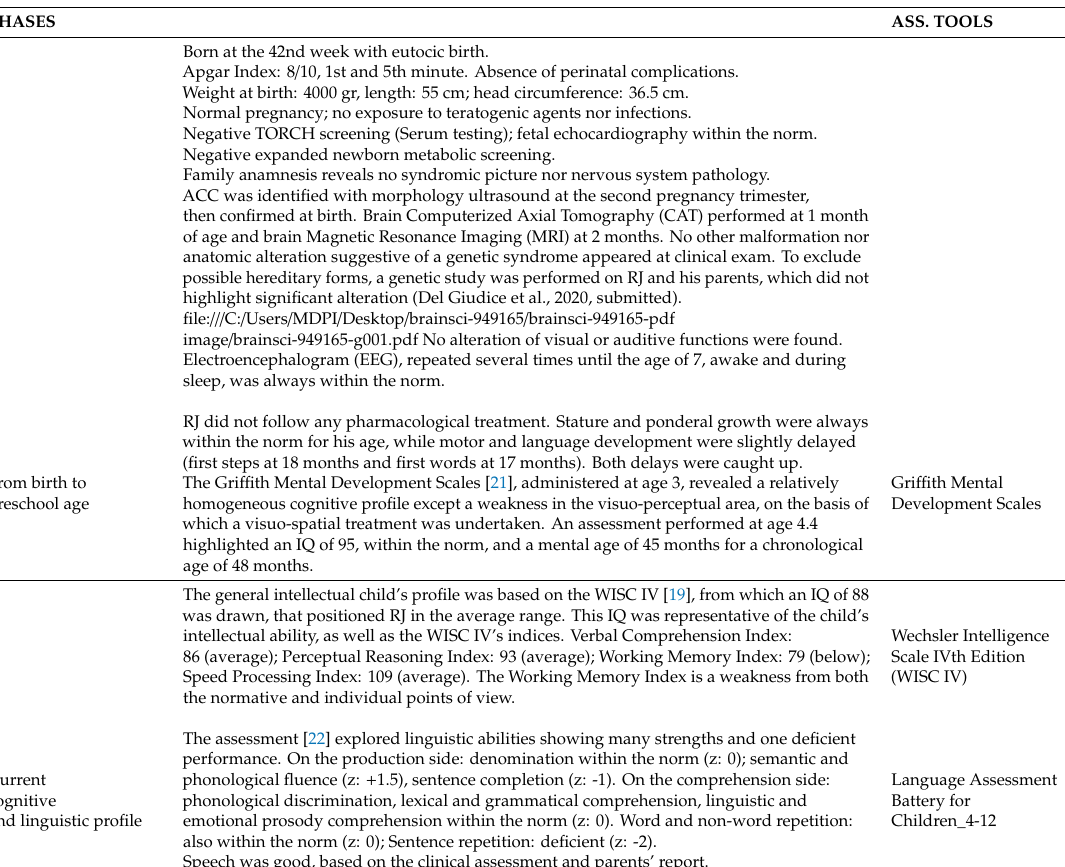
RJ’s clinical history and current cognitive and linguistic profile: phases, data, and assessment